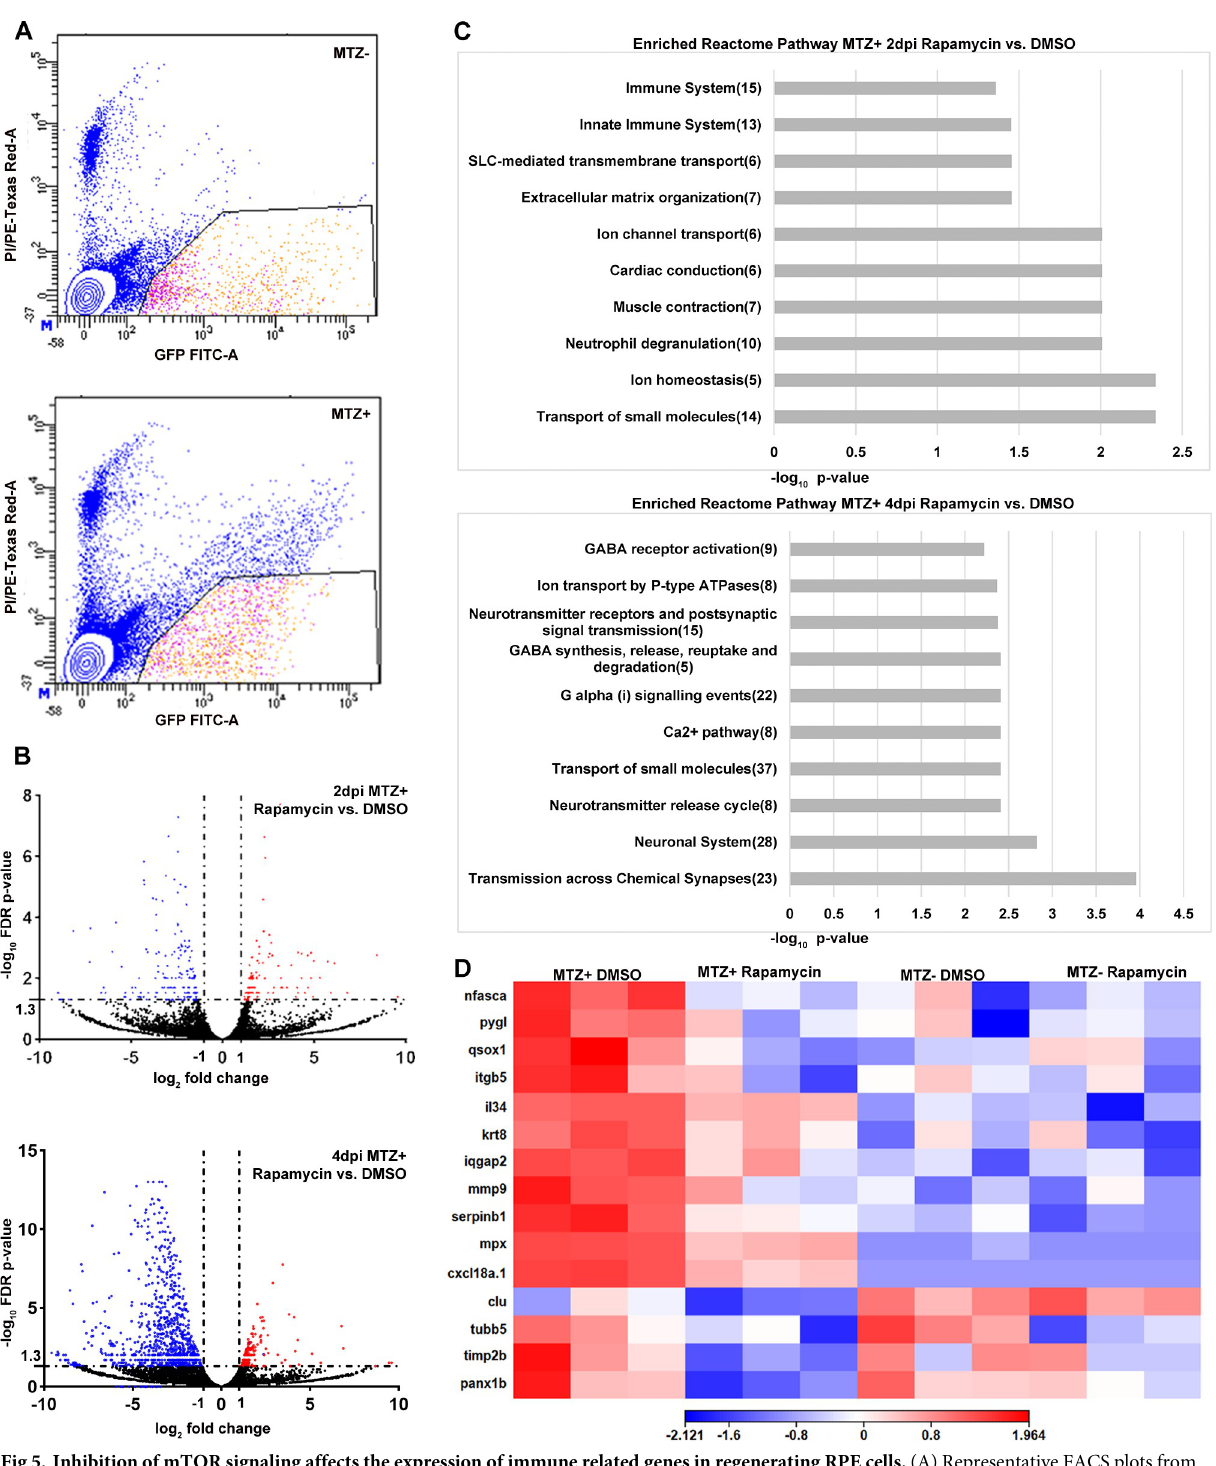
Fig 5. Inhibition of mTOR signaling affects the expression of immune related genes in regenerating RPE cells. (A) Representative FACS plots from MTZ - and MTZ + samples to show gating parameters used to isolate GFP + PI - RPE cells (B) Volcano plots showing differentially expressed genes between MTZ + rapamycin-treated and DMSO-treated groups at 2dpi and 4dpi. Dashed lines indicate the threshold criteria. Each dot represents an individual gene; red dots represent significantly upregulated DEGs, blue dots represent significantly downregulated DEGs, and black dots represent non-significant genes. (C) Pathway enrichment analysis on the significantly downregulated 2dpi and 4dpi DEGs. Numbers in parentheses are the gene counts enriched in each pathway. (D) Hierarchical clustering heatmap of the 15 genes enriched in the 2dpi immune system Reactome pathway across all four